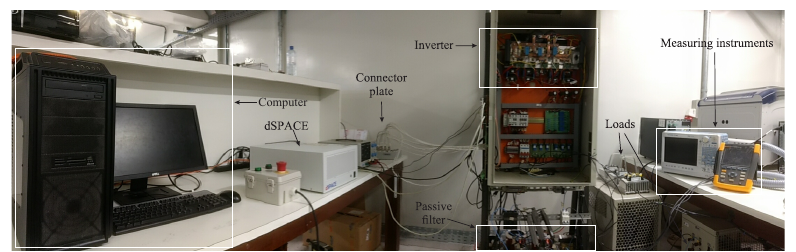
Figure 6. General view of the experimental test bench.